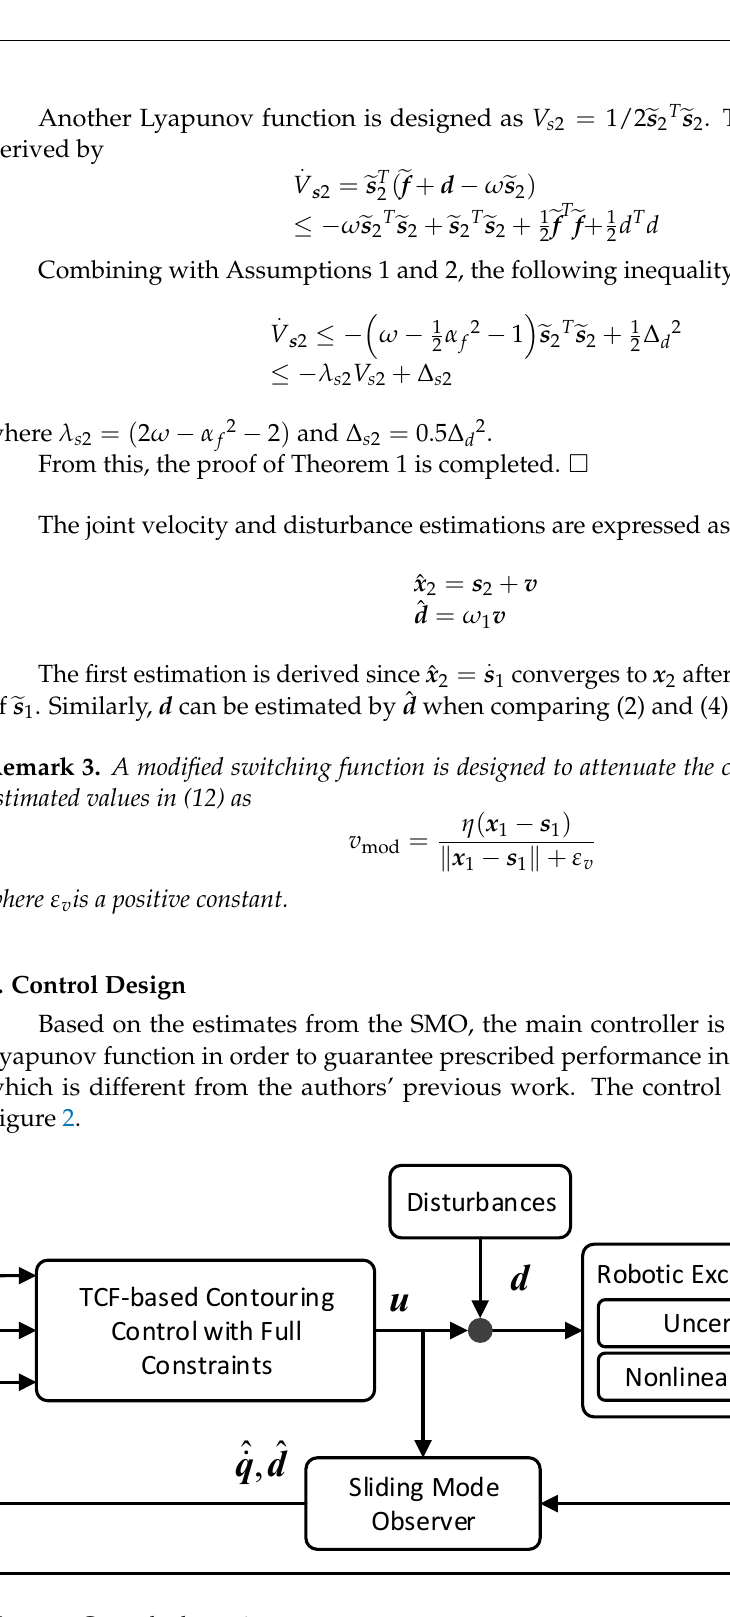
Figure 2. Control Figure 2. Control schematics.